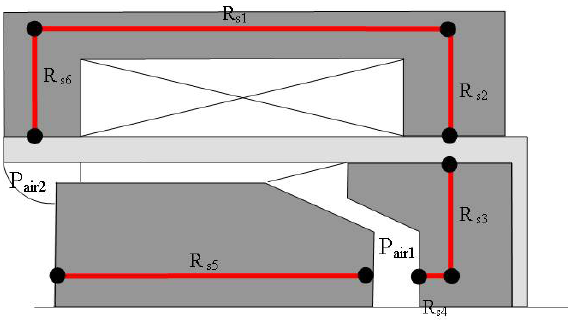
Figure 9. Magnetic flux path of the metal zone. Table 3. Permeance parameter of metal zone.